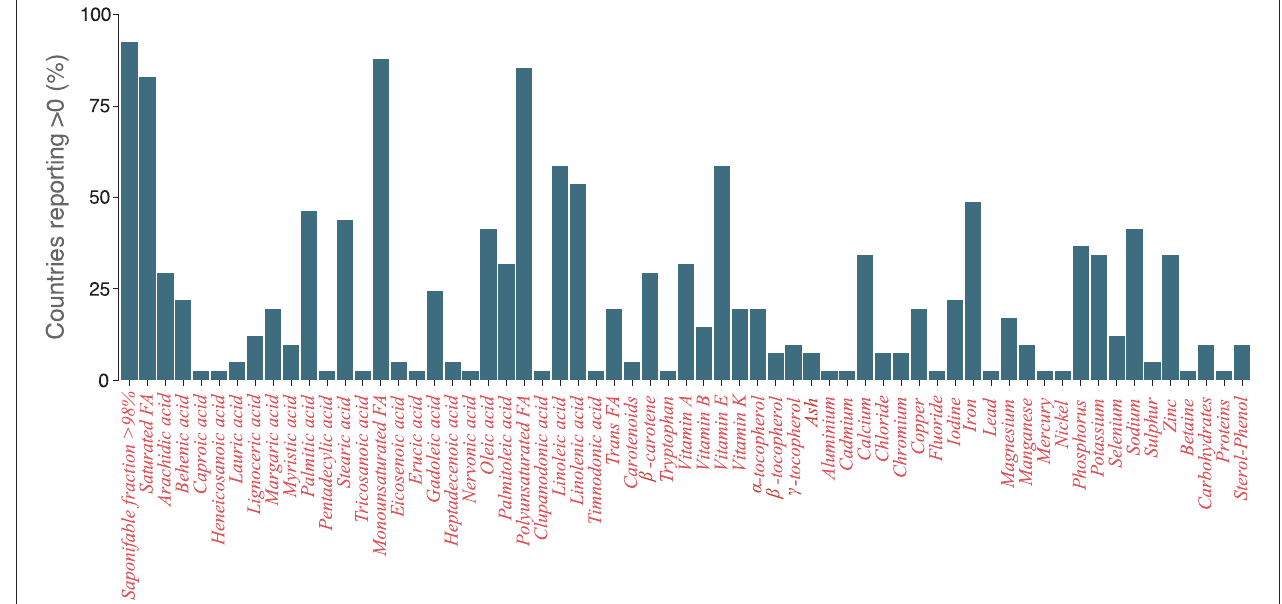
FIGURE 2 | Percentage of countries whose food composition table quantifies each chemical compound for olive oil. We include as a quantified chemical those with an estimated quantity larger than 0, regardless of the specific amount or units shown in the database.